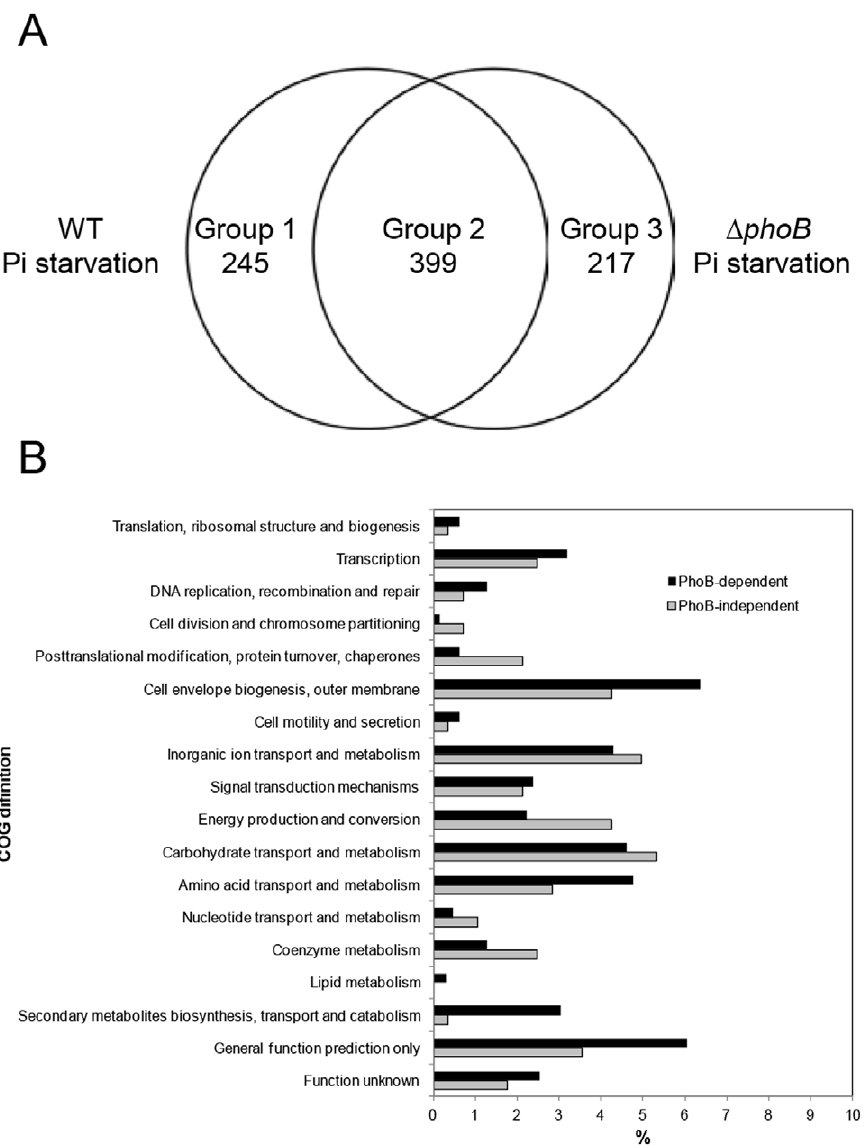
Figure 6. PhoB-dependent genes in B.fragilis . (A) Classification of genes whose expression levels were altered more than 4-fold under Pi limitation (0.0066 mM of KH 2 PO 4 ) in wild type and D phoB mutant strains, compared to levels in wild type in the presence of sufficient Pi (6.6 mM of KH 2 PO 4 ). Left and right circles indicate the differentially expressed genes of wild type and D phoB mutant strains with expressions that were altered over 4-fold under Pi limitation. Group 1: includes 245 PhoB-dependent Pi-response genes. Group 3:217 PhoB-dependent genes unrelated to Pi response. Group 2 contains two subgroups. Group 2a: 276 PhoB-independent Pi-response genes (fold change in expression in response to Pi- limitation was similar between wild type and D phoB mutant strains); Group 2b: 123 PhoB-dependent Pi response genes (the extent of change in expression in response to Pi-limitation was different . 2-fold between wild type and D phoB mutant strains). (B) COG classification of PhoB-dependent (black bar) and PhoB-independent (white bar) genes that are differentially expressed during Pi starvation. The percentage of genes classified into each COG category is relative to the total number of genes in each group. Fifty-five percent of the PhoB-dependent (585 genes) and 60% of the PhoB-independent (276 genes) groups could not be assigned to a COG category (that data are not included in this figure). operon (512-bp fragment) but not to another DNA fragment used as a control (290-bp internal fragment of BF3397) (Figure 5B).